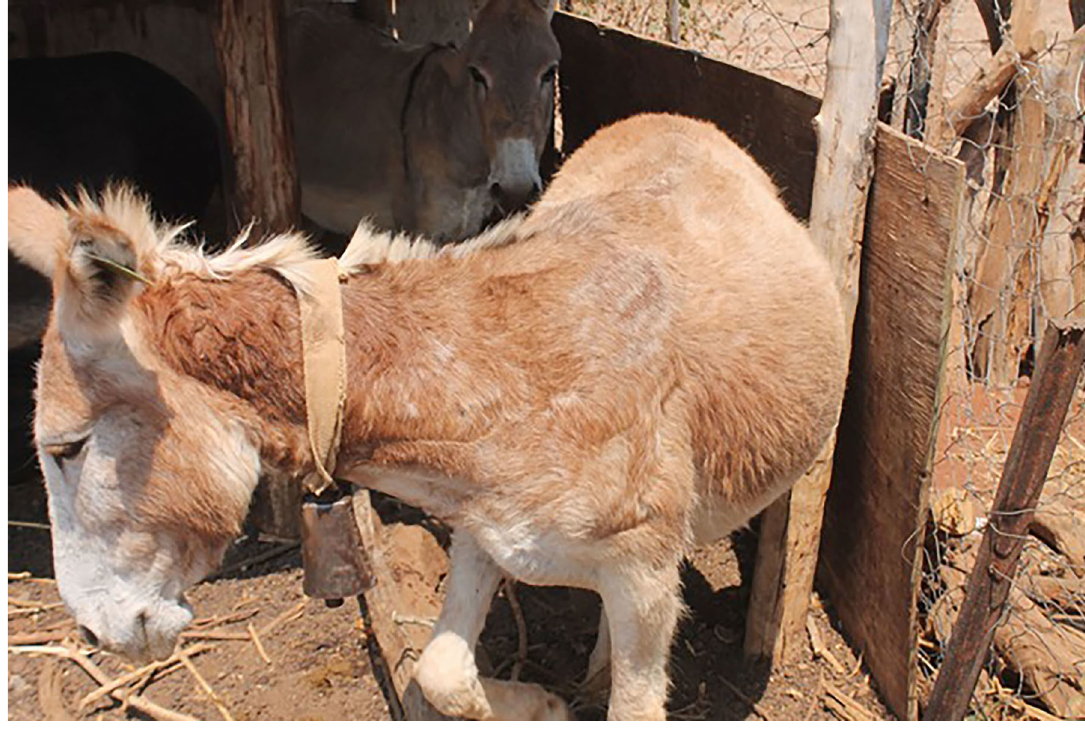
Fig 4. Light brown donkey.